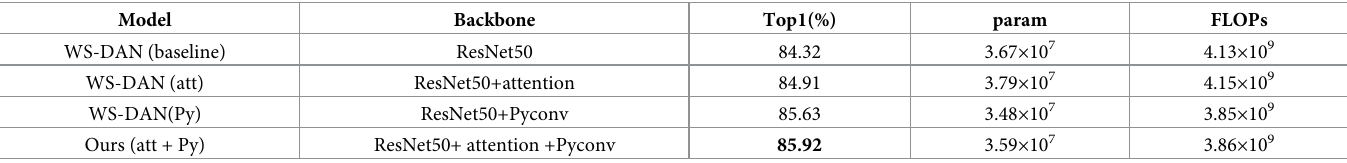
Table 4. Experimental results of ablation. Top1 accuracy (%) on CUB-200-2011.